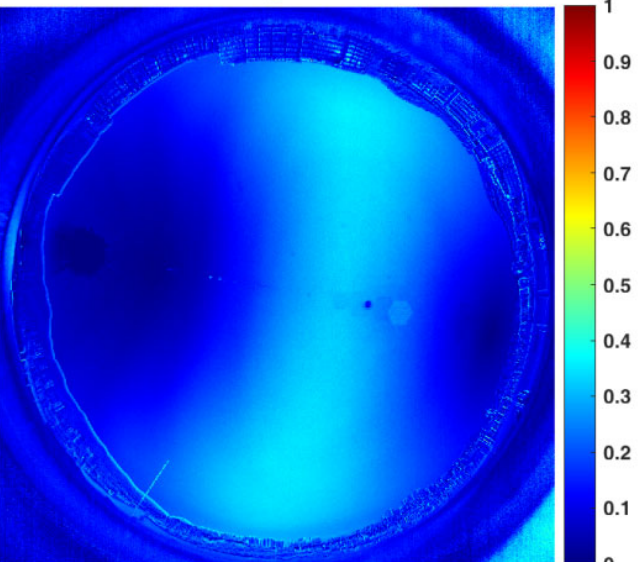
Figure 7. Sky polarization distribution results obtained by the image fusion algorithm. To compensate the mismatch of the cloud distribution caused by the time difference between the overexposed and underexposed images, we use an external trigger for timing control, and the time difference is compressed to less than 200 ms. Thus, the mismatch can be